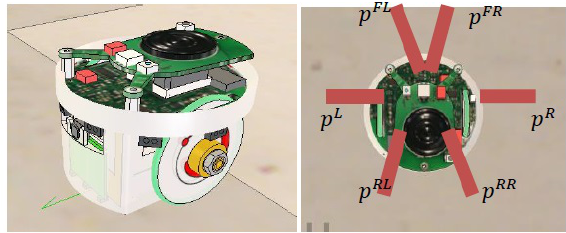
Figure 7: ePuck robot simulated using the v-rep simulator. Side view (left) and top view showing IR sensor locations